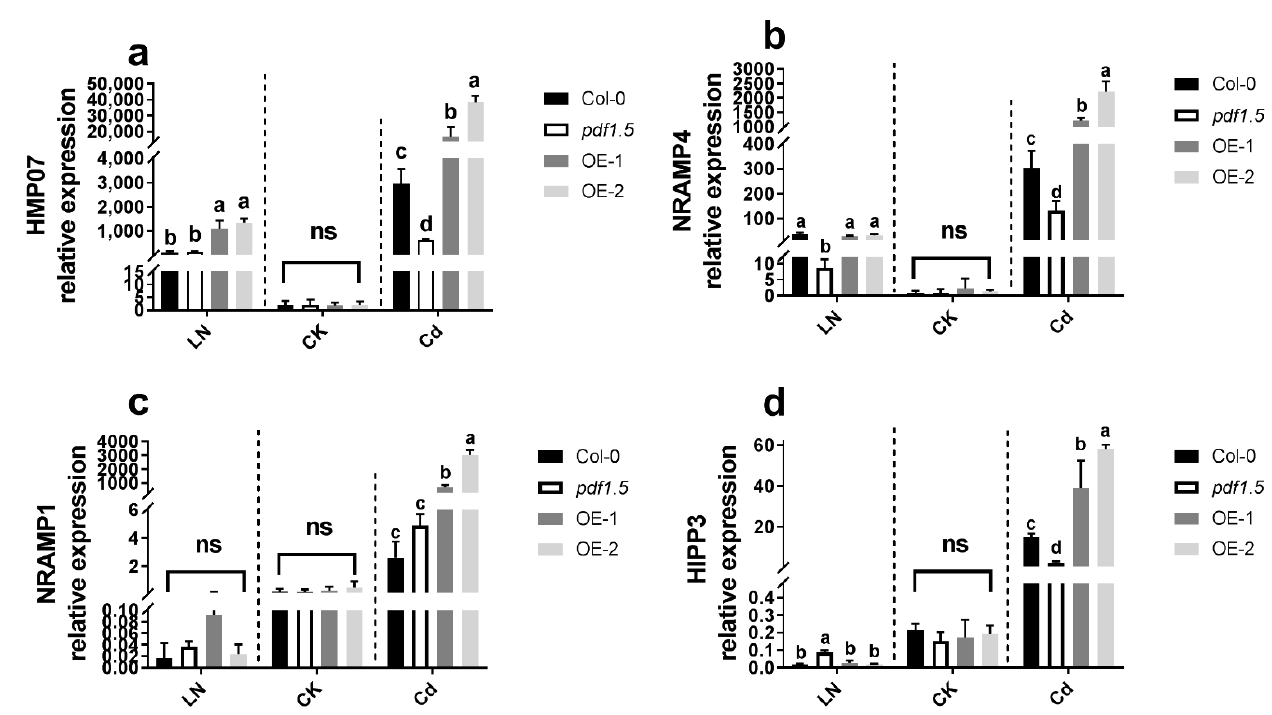
Figure 8. AtPDF1.5 involved the gene’s expression for metal transporter. ( a ) AtHMP07 relative expression for different materials grown in LN or CK or Cd conditions. ( b ) AtNRAMP4 relative expression for different materials grown in LN or CK or Cd conditions. ( c ) AtNRAMP1 relative expression for different materials grown in LN or CK or Cd conditions. ( d ) AtHIPP3 relative expression for different materials grown in LN or CK or Cd conditions. Bar height represents mean and error bars indicate standard deviation. Different letters on bars indicate significant differences based on Tukey’s HSD ( p < 0.05). The statistical analysis was performed on different treatment genotypes. Six replicates were used for measurements.